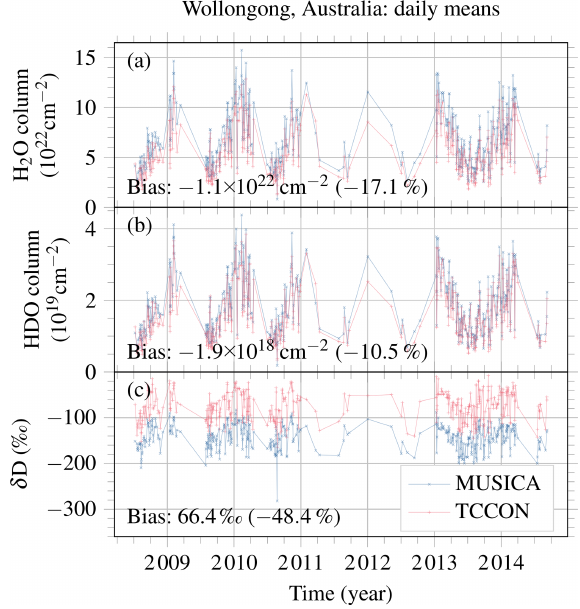
Figure 3. Time series of daily averages of H 2 O (a) , HDO (b) and a posteriori δ D (c) of the NDACC-MUSICA type 2 (blue crosses) and TCCON (red pluses) data products at Wollongong, Australia. The bias in δ D without daily averaging is 65.8‰ ( − 47 .